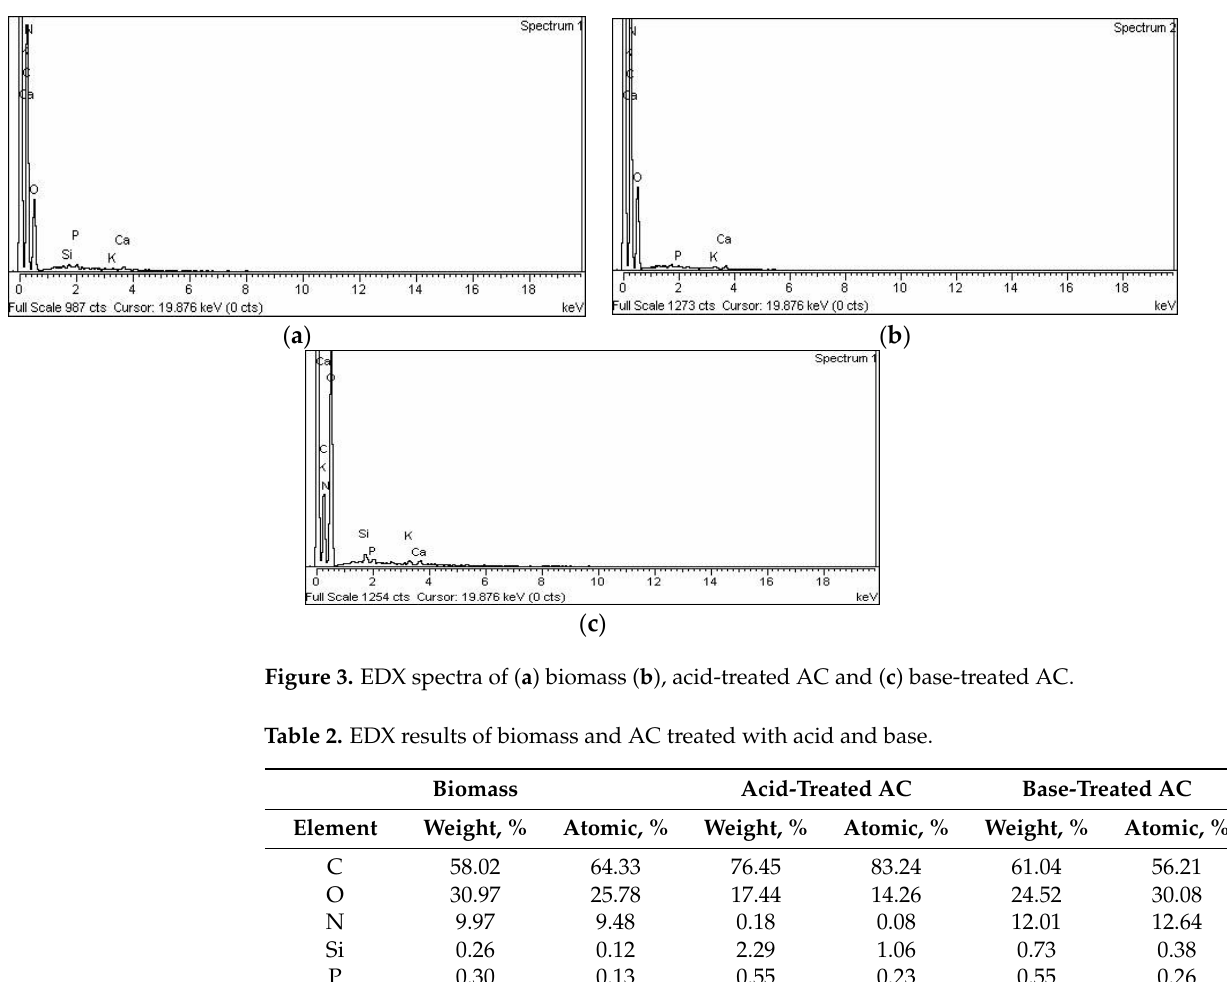
Figure 2. SEM images of ( a ) biomass, ( b ) acid-treated AC and ( c ) base-treated AC.